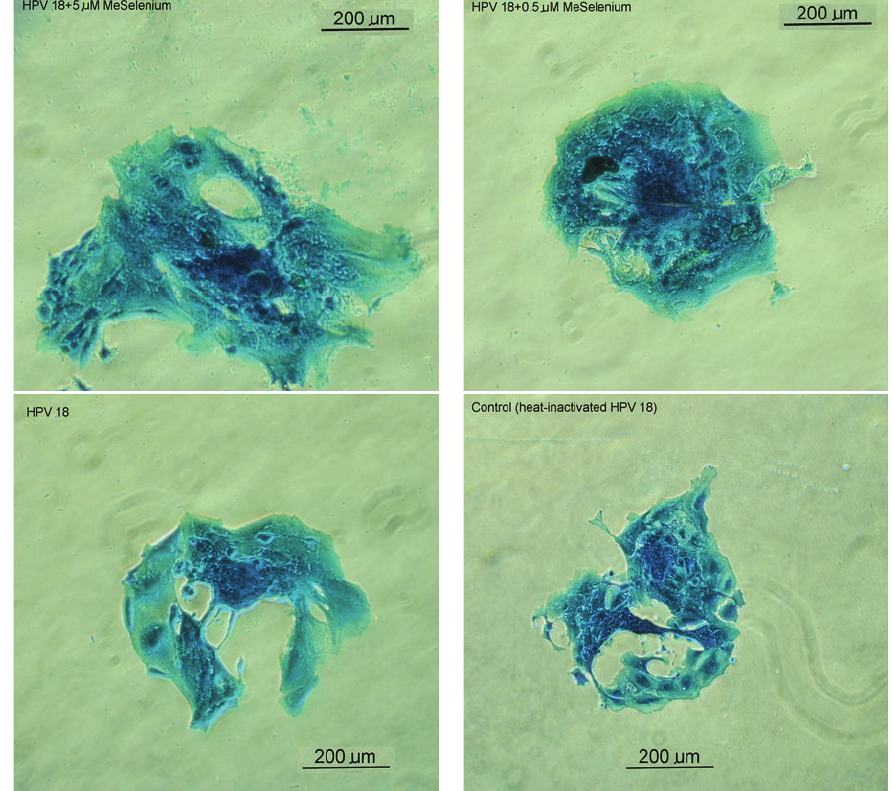
Figure 1: Implanted mouse trophoblasts cells after 48-hour exposure (at 37 ∘ C, 5% CO 2 in air) to either (1) control medium with heat- inactivated HPV-18 HeLa lysate, (2) HPV-18 HeLa lysate, (3) HPV-18 HeLa lysate and 0.5 𝜇 M selenomethionine (SeMet), or (4) HPV-18 HeLa lysate and 5.0 𝜇 M SeMet. The stain used was Rose Bengal and Fast Green-based Spermac staining kit and images were taken using the Nikon Diaphot inverted microscope (400x magnification). The cell sizes for the images were as follows: (1) control, 515 𝜇 , (2) HPV-18 HeLa lysate, 609 𝜇 , (3) HPV-18 HeLa lysate with 0.5 𝜇 M SeMet, 622 𝜇 , and (4) HPV-18 HeLa lysate with 5.0 𝜇 M SeMet, 915 𝜇 at the greatest